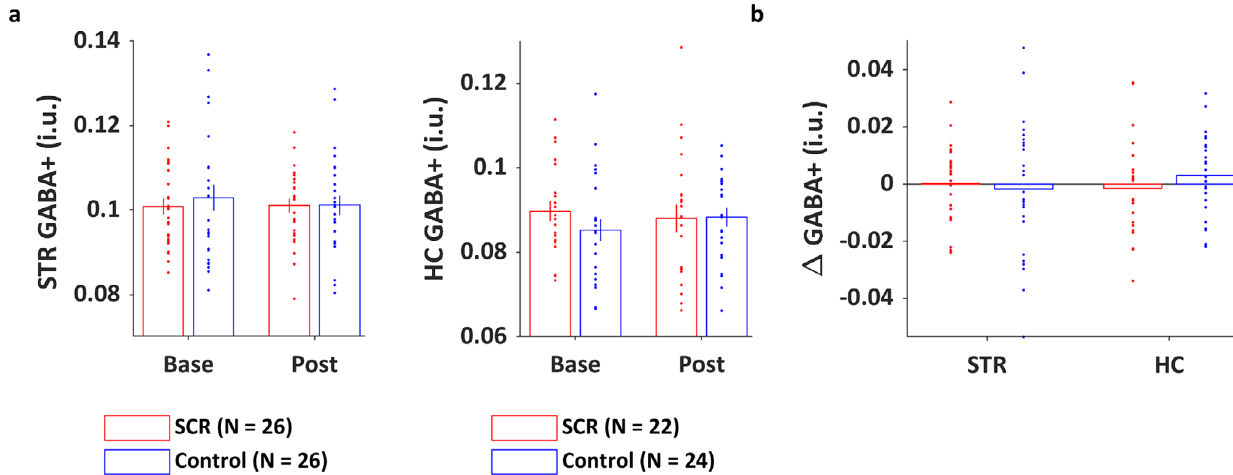
Fig. 4 GABA + levels and GABA + changes. a Individual GABA + levels for each time point plotted on top of group average for the SCR and control groups. There were no effects of time, group or any group by time interactions. Error bars re fl ect SEM. b Individual GABA + changes ( Δ GABA + ) plotted on top of group average. These values were used in regression analyses to assess the link between GABA + and both motor performance and BOLD. Consistent with the analyses of the data depicted in a , there were no differences in Δ GABA + between groups (unpaired two-sample t -tests, all p s > 0.1). Positive values